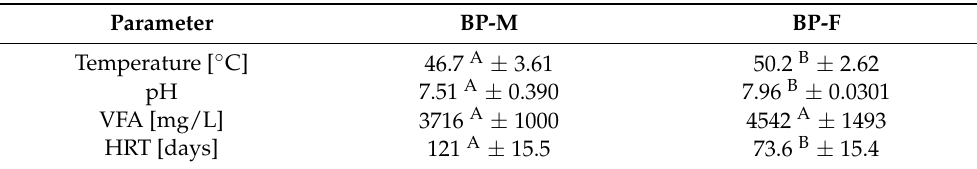
Table 5. Selected parameters of the methane fermentation process in the fermentation tanks of the biogas plants.